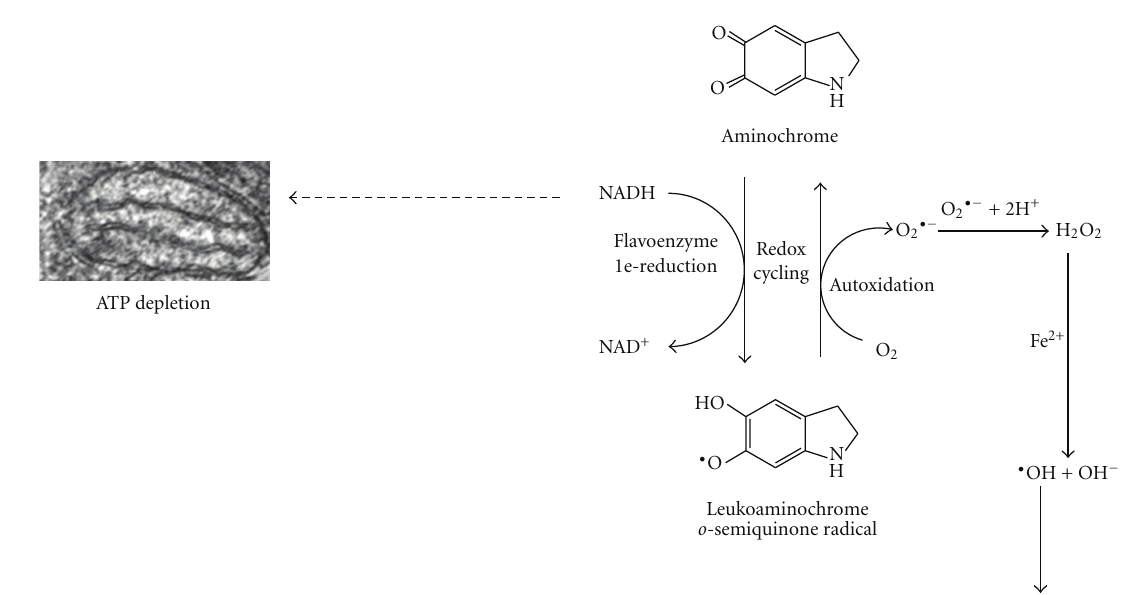
named the glutathione to cysteil conjugate. Thus, 5-gluta- thionyl-dopamine is converted to 5-cysteinyl